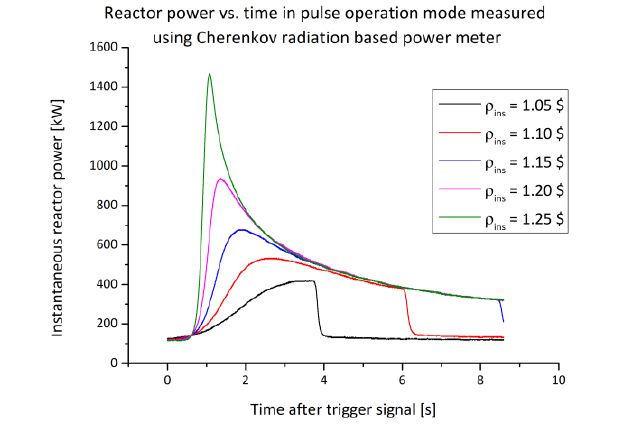
Fig. 11. Measured SiPM signal during reactor pulse operation, with power calibration factor